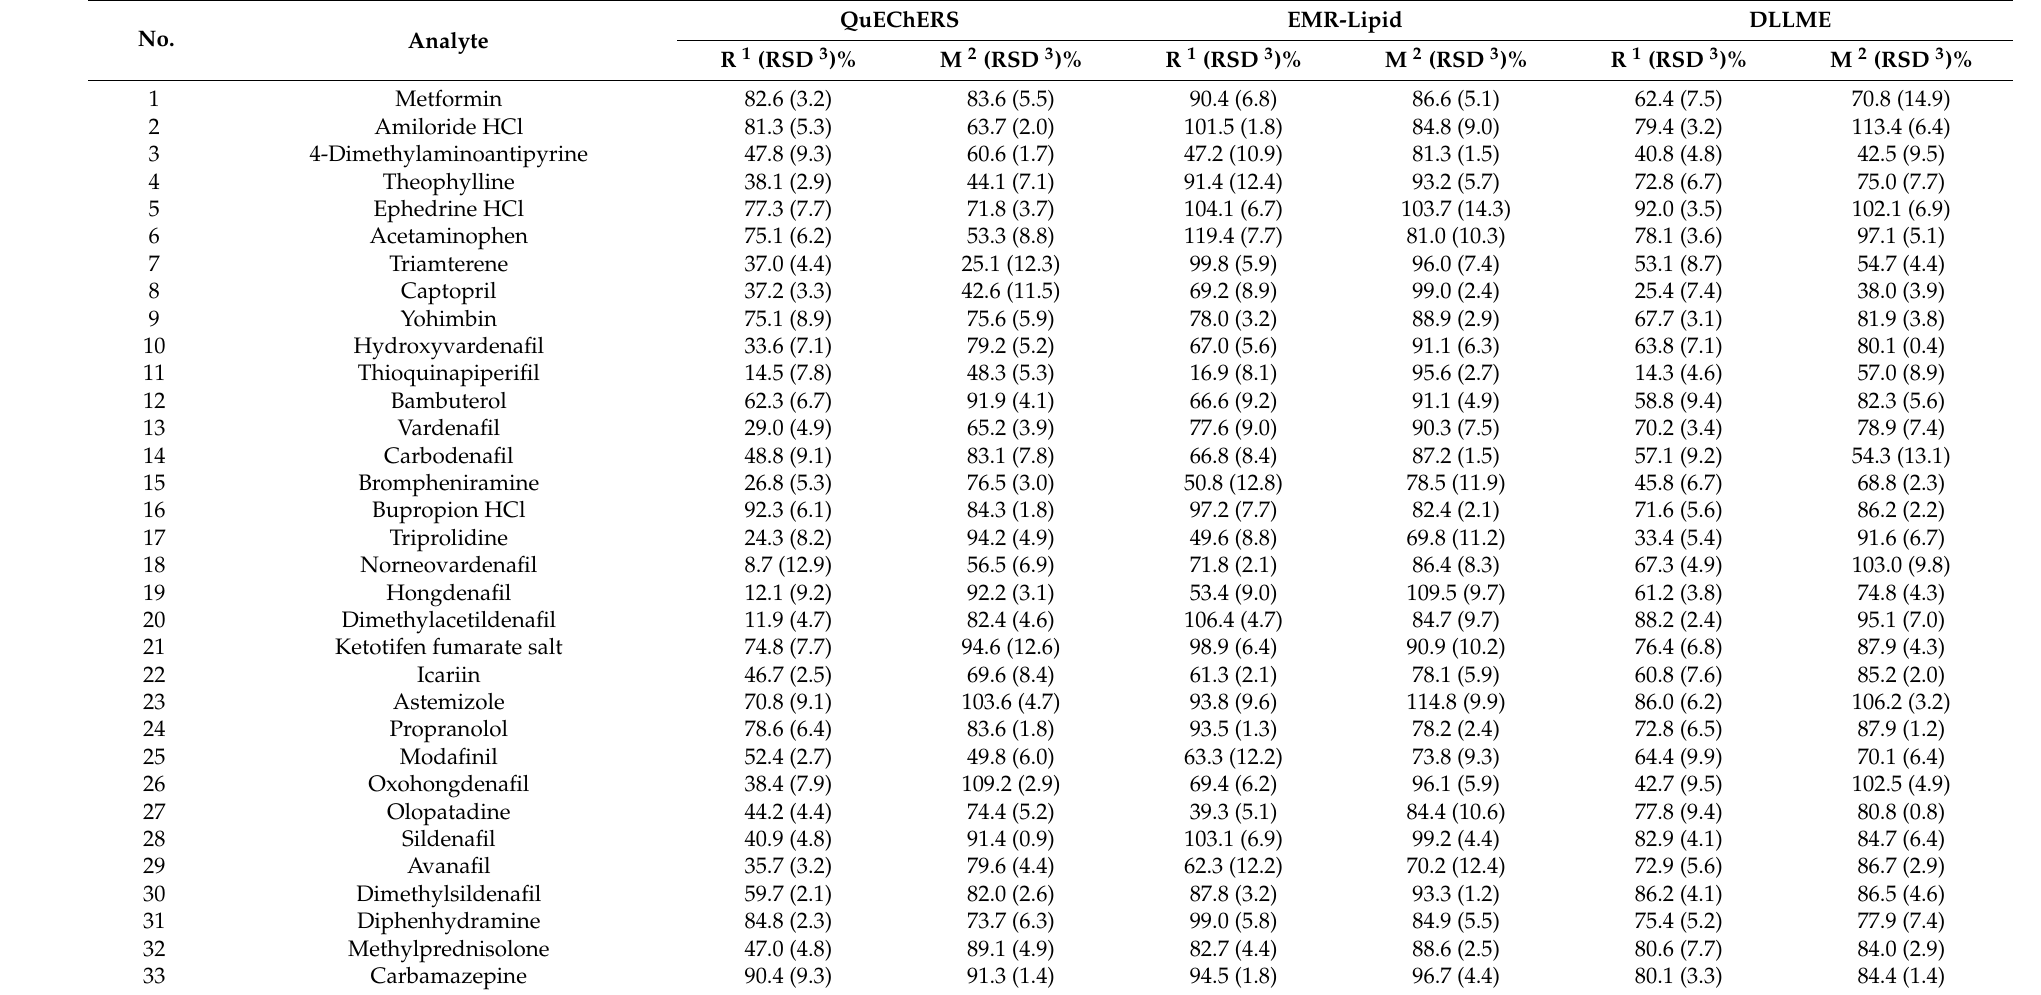
Table 1. Recovery rates (%) and matrix effects (%) of 92 adulterants in soft-gel samples at 2 µ g/g level ( n = 3) by three pretreatment methods.